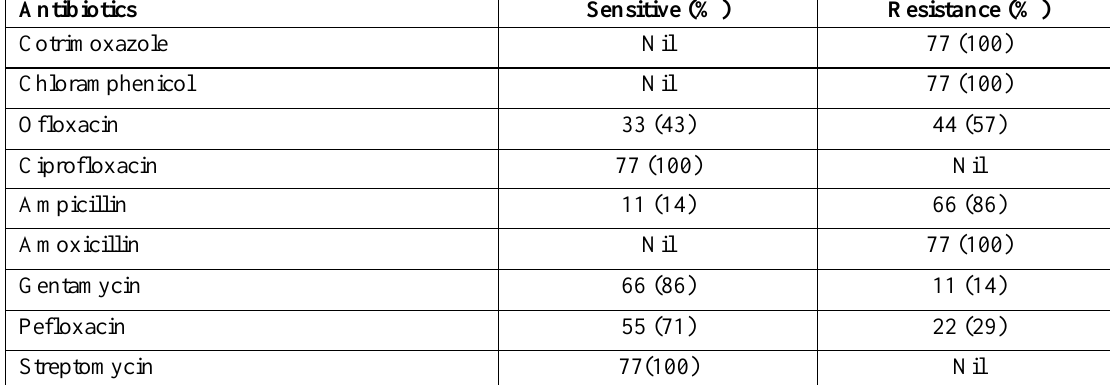
Table 2. Susceptibility pattern of Salmonella sp. to conventional